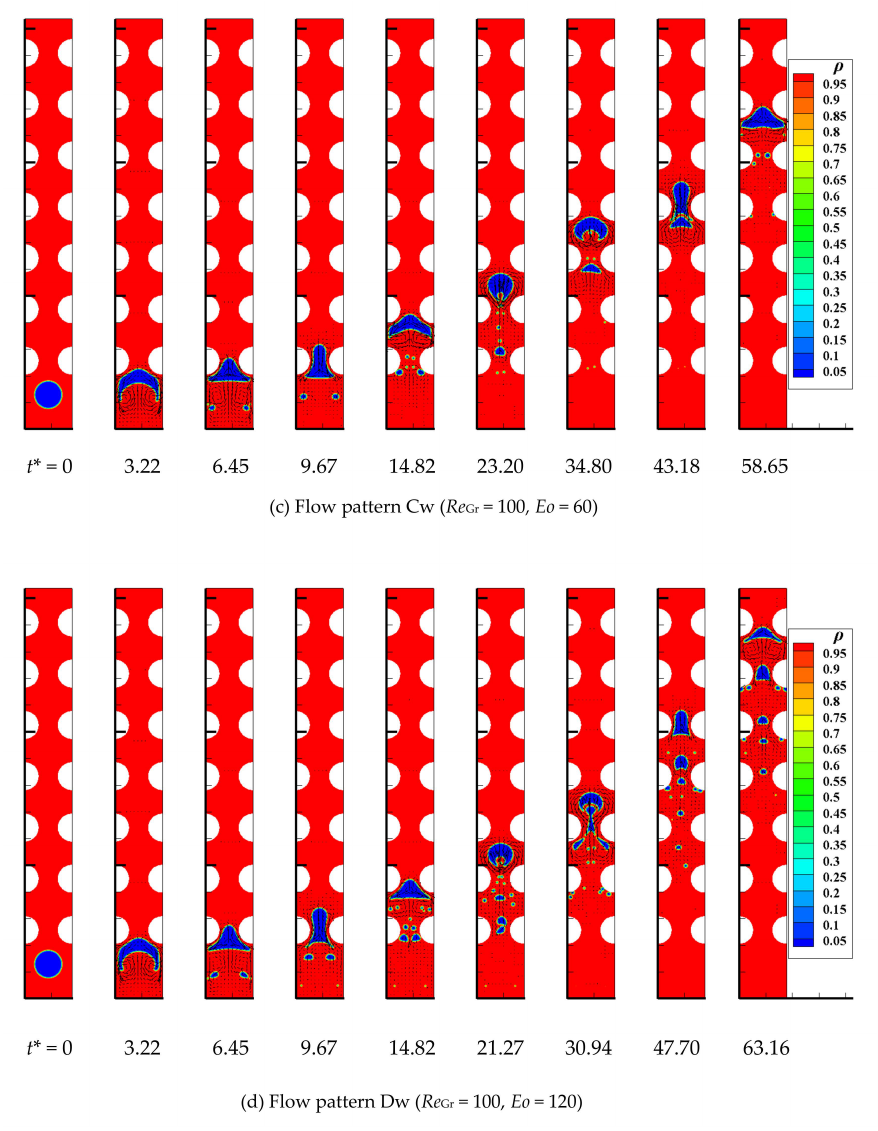
Figure 13. Bubble evolution diagrams of flow patterns Aw ( a ), Bw ( b ), Cw ( c ), and Dw ( d ) in the wavy vertical channel with L / D b =